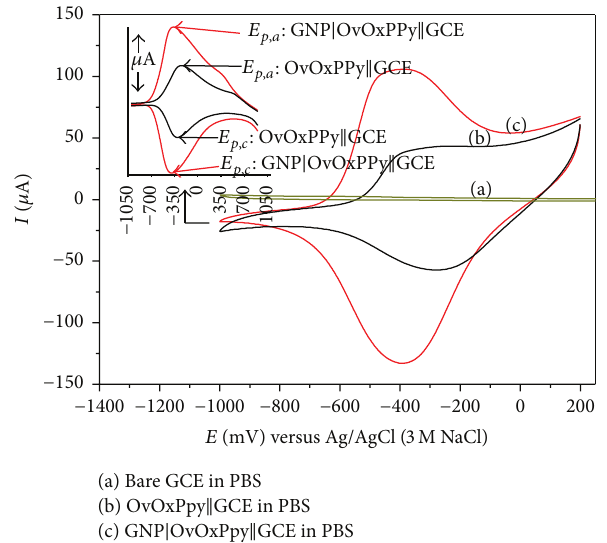
Figure 3: Cyclic voltammogram of GCE (a), OvOxPpy || GCE (b), and GNP | OvOxPpy || GCE (c), in PBS (pH 7.4) at 70 mV/s versus Ag/AgCl (inset): SWV of OvOxPpy || GCE and the GNP | OvOxPpy || GCE composite